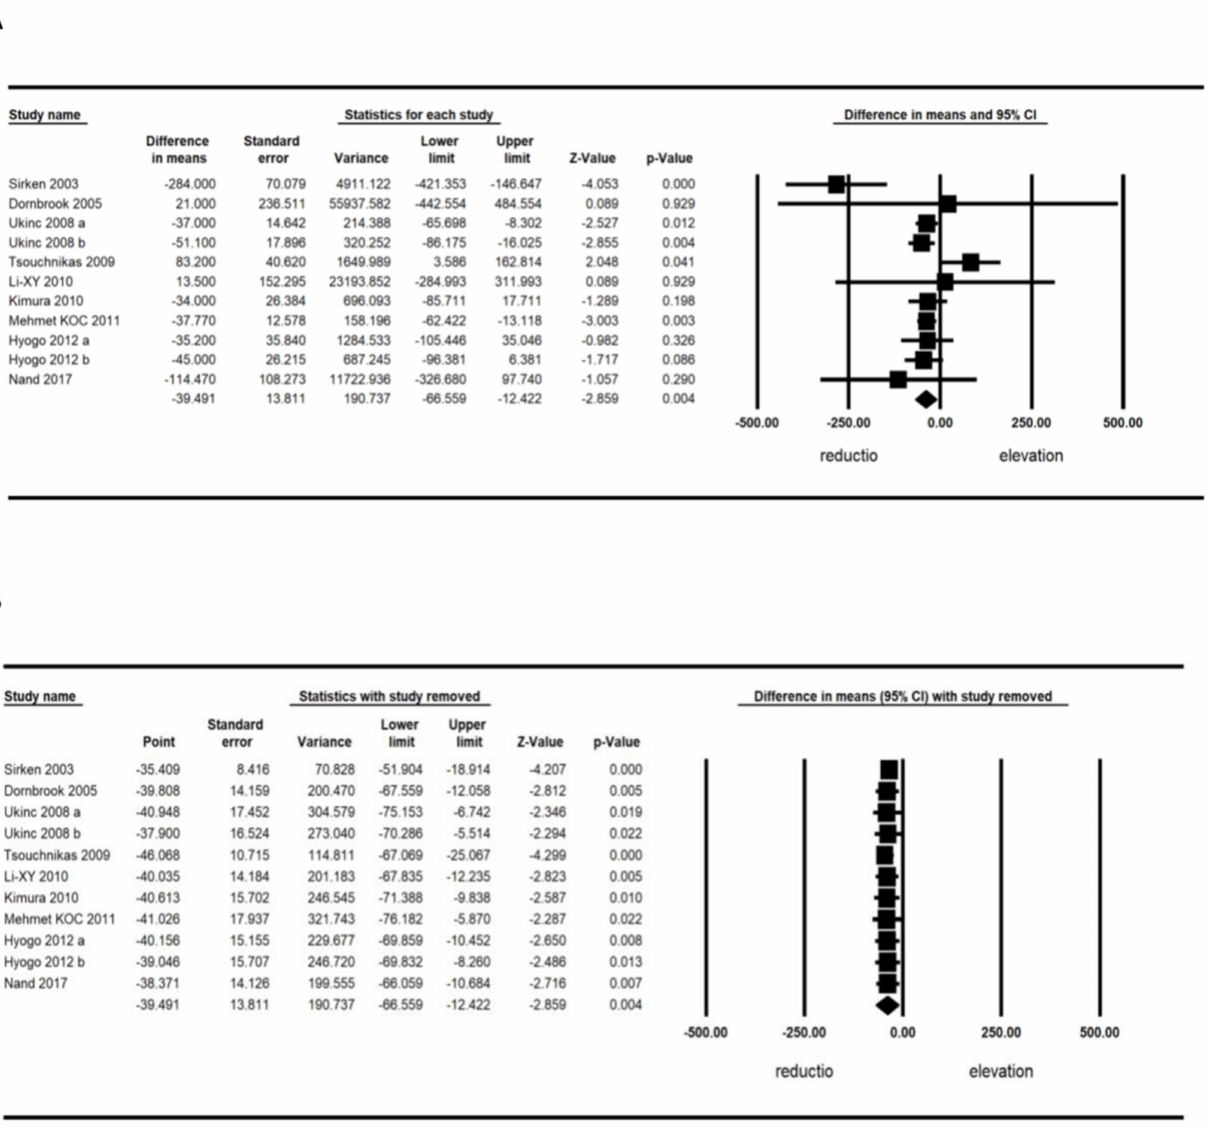
Figure 2. ( A ) Forest plot displaying standardized mean differences and 95% confidence intervals showing the consequence of statin treatment on serum ferritin level. ( B ) Leave-one-out sensitivity analyses